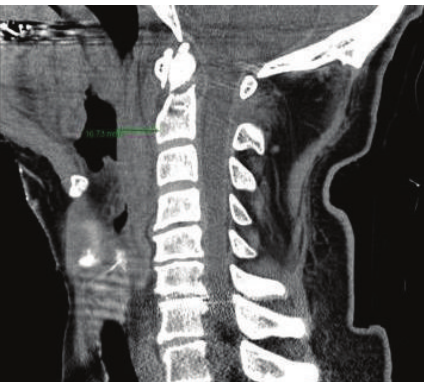
Figure 6: Midsagittal CT soft tissue window demonstrating pre- vertebral soft tissue swelling of 16.7 mm which is excessive for a transverse Type 2 dens